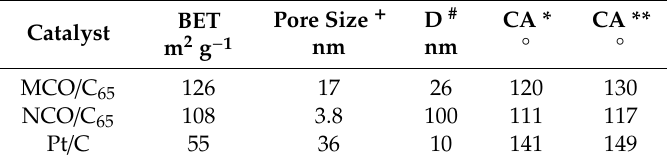
Table 1. Physical properties of bifunctional catalysts.